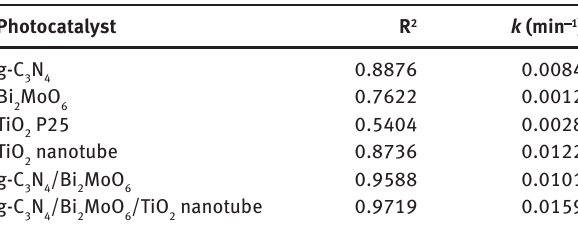
Table 1: Kinetic constants for the photocatalytic decolorization of reactive black 5 dye.